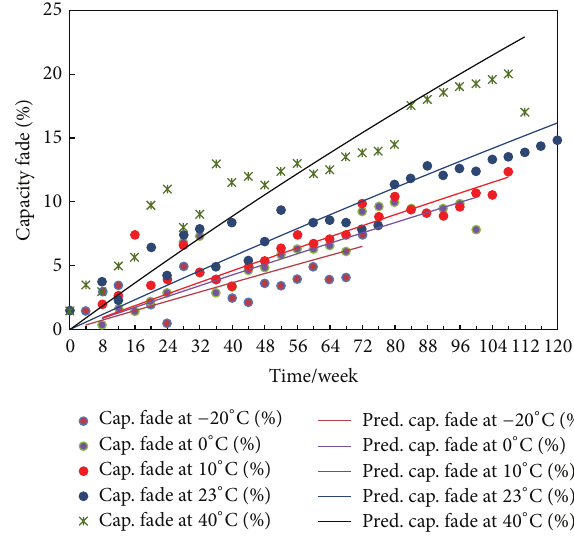
Figure 7: Percentage capacity loss versus time for SAFT cell at − 20 ∘ C, 0 ∘ C, 10 ∘ C, 23 ∘ C, and 40 ∘ C.